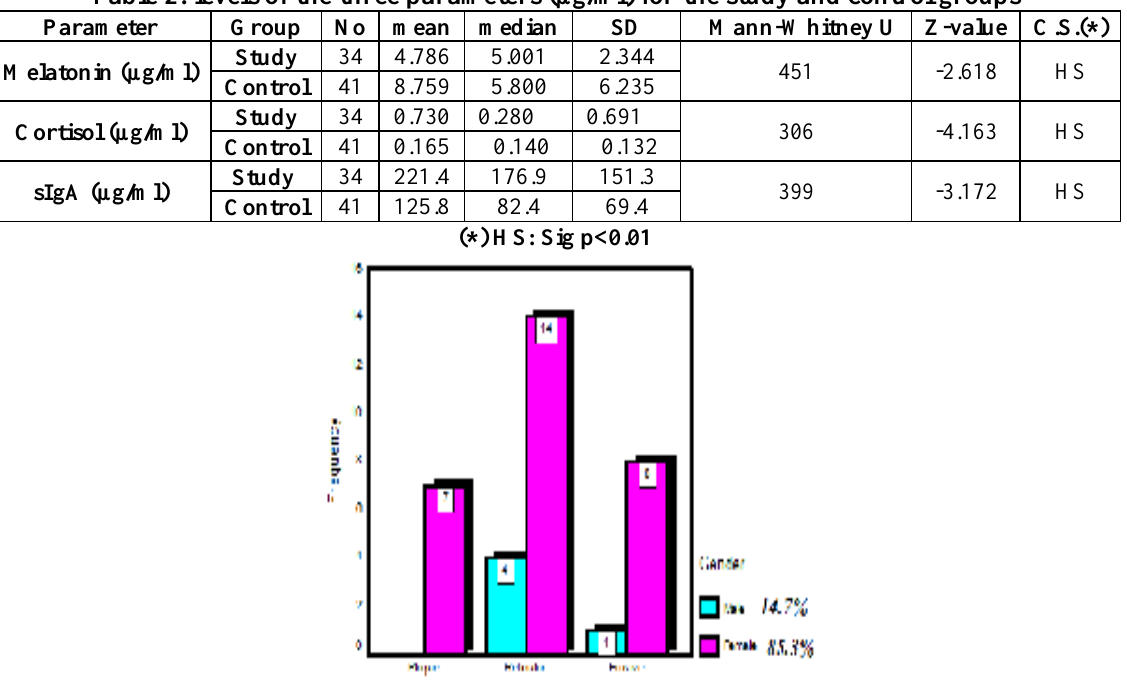
Table 2: levels of the three parameters (µg/ml) for the study and control groups